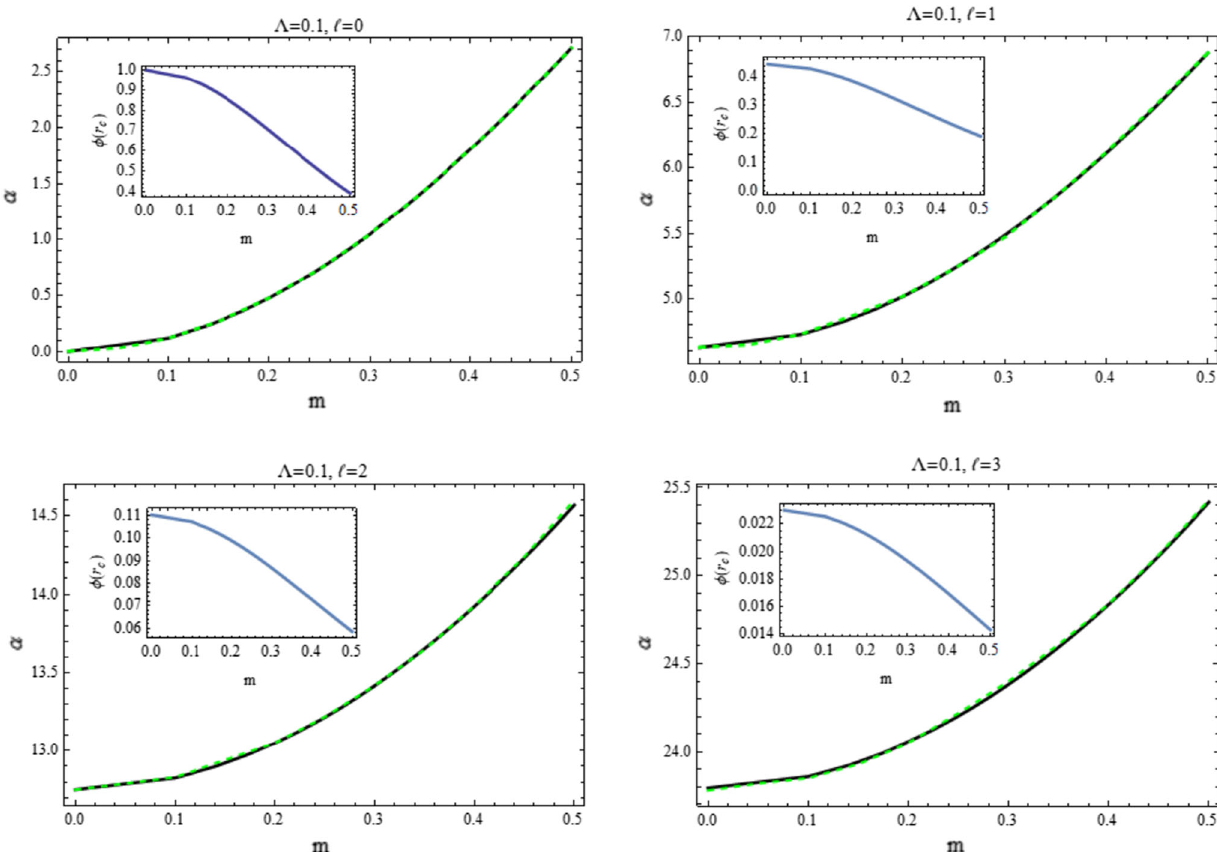
Fig. 13 The coupling parameter against the mass of scalar field for the critical SdS black hole that admits a spherical massive scalar could with the lowest state with k = 0 for various modes, and the insets exhibit the corresponding values of scalar field at r c . Here we have set M = 1 and φ( r ) = e